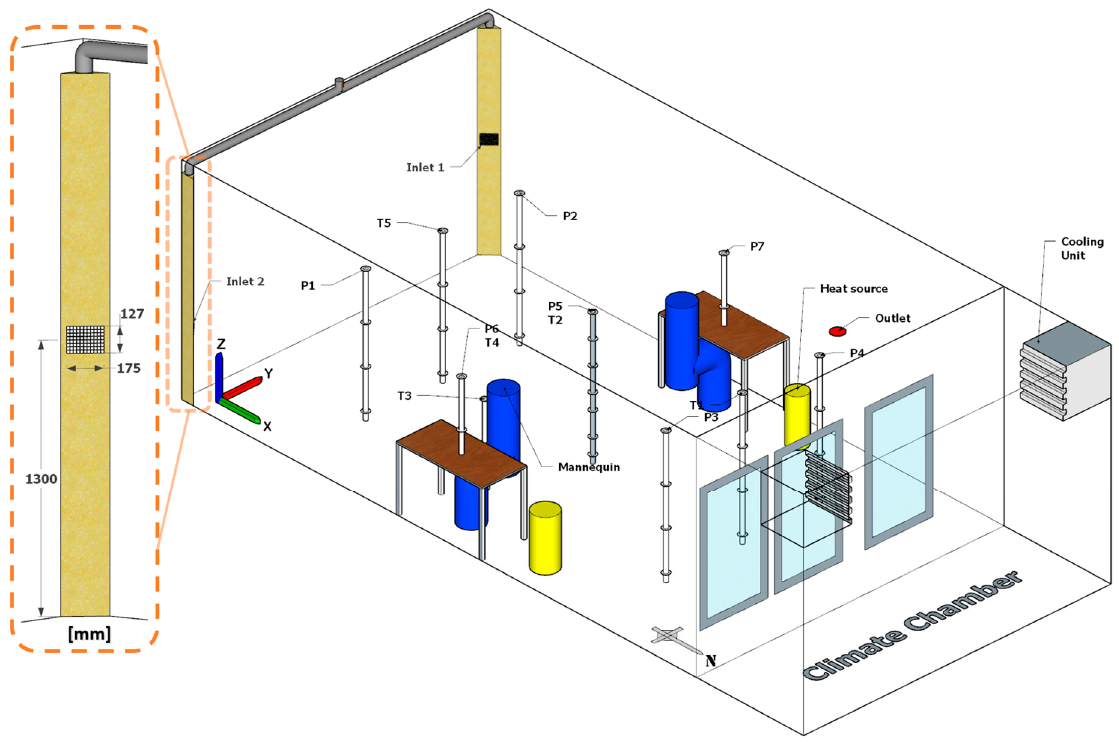
Figure 1. Isometric layout of the mock-up office test chamber.